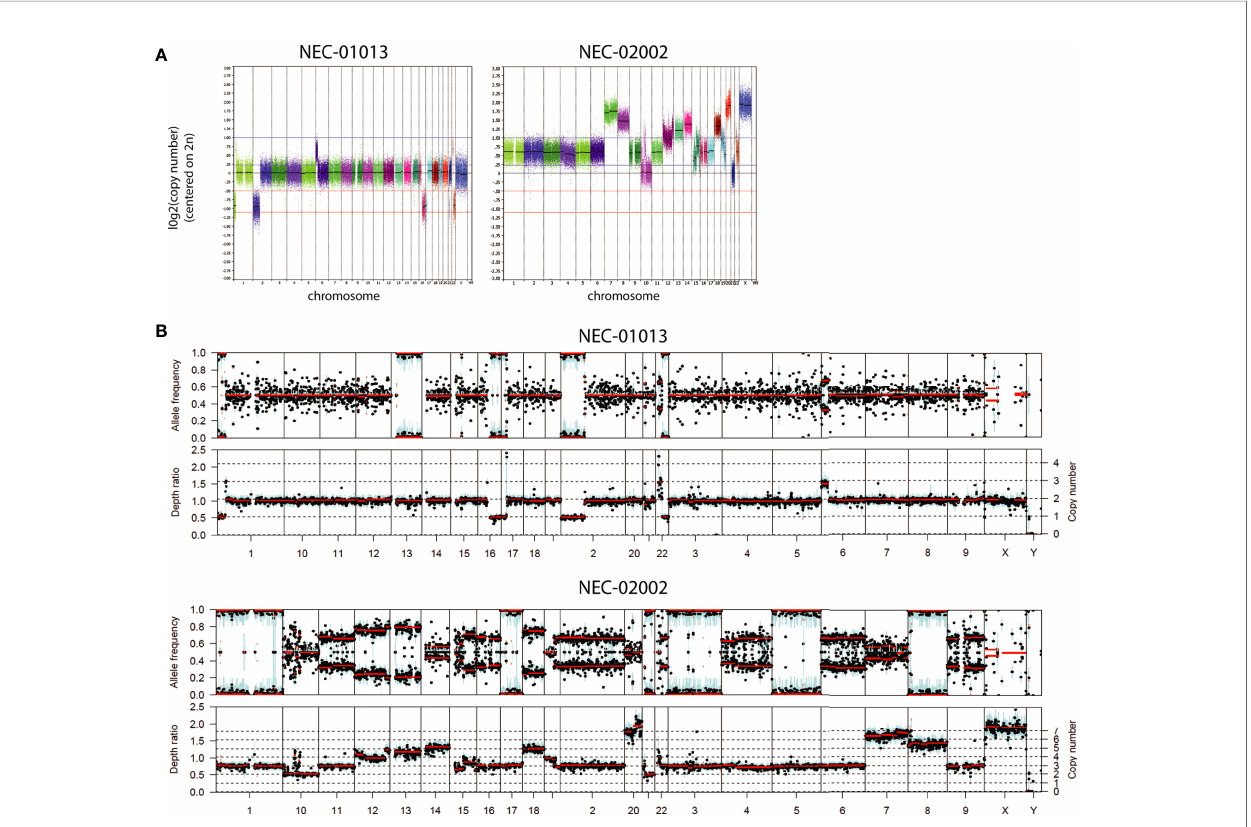
FIGURE 3 | Copy number pro fi les of GEP-NEC organoids. (A) Copy number pro fi les of GEP-NEC organoids are generated based on low-coverage whole genome sequencing and represented on a log 2 scale. NEC-01013: passage (P) 11; NEC-02002: P5. (B) Copy number pro fi les were based on SNPs identi fi ed by whole exome sequencing and analyzed by Sequenza. Allele frequencies are given as ratios and used to infer copy number. NEC-01013: P11; NEC-02002: